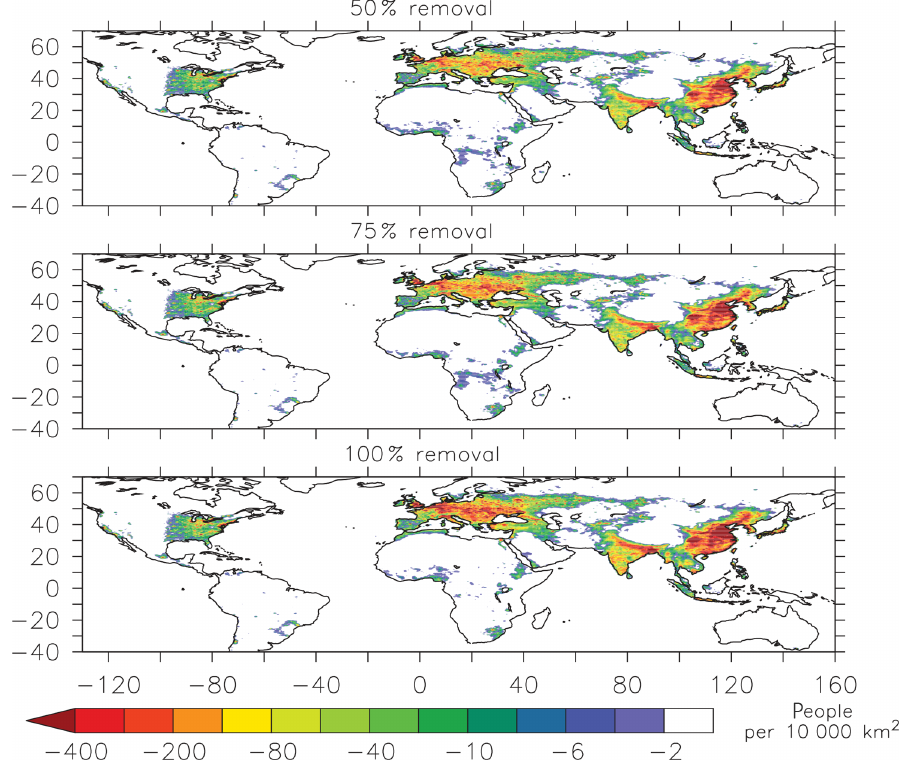
Figure 7. Annual average mortality attributable to PM 2 . 5 concentration changes (in people/10000km 2 ) from the three scenarios with agri- cultural emissions reductions of 50, 75 and 100% ( a , b and c , respectively). Table 4. Mortality attributable to air pollution in 1000 peopleyr − 1 . In parenthesis the minimum-maximum